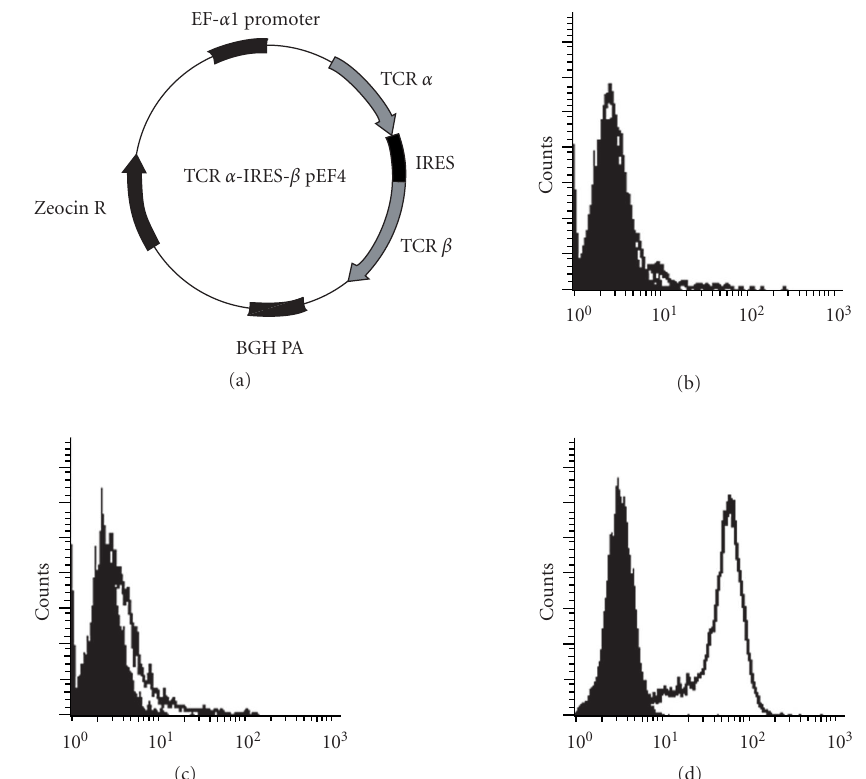
Figure 1: Expression of the TRAZ from MA CTL clone on the surface of a TR-deficient Jurkat line (JRT3-T3.5) . (a) The TR-ALPHA-IRES- TR-BETA cassette was cloned into the pEF4 expression vector. (b) Untransfected JRT3-T3.5, (c) JRT3-T3.5 cells transfected with the TCRB sequence, or (d) JRT3-T3.5 cells transfected with MA TR-ALPHA-IRES-TR-BETA pEF4 were stained with anti-CD3 Epsilon (open his- togram) or with isotype control (filled histogram). IRES stands for internal ribosomal entry site. Zeocin is antibiotic resistance